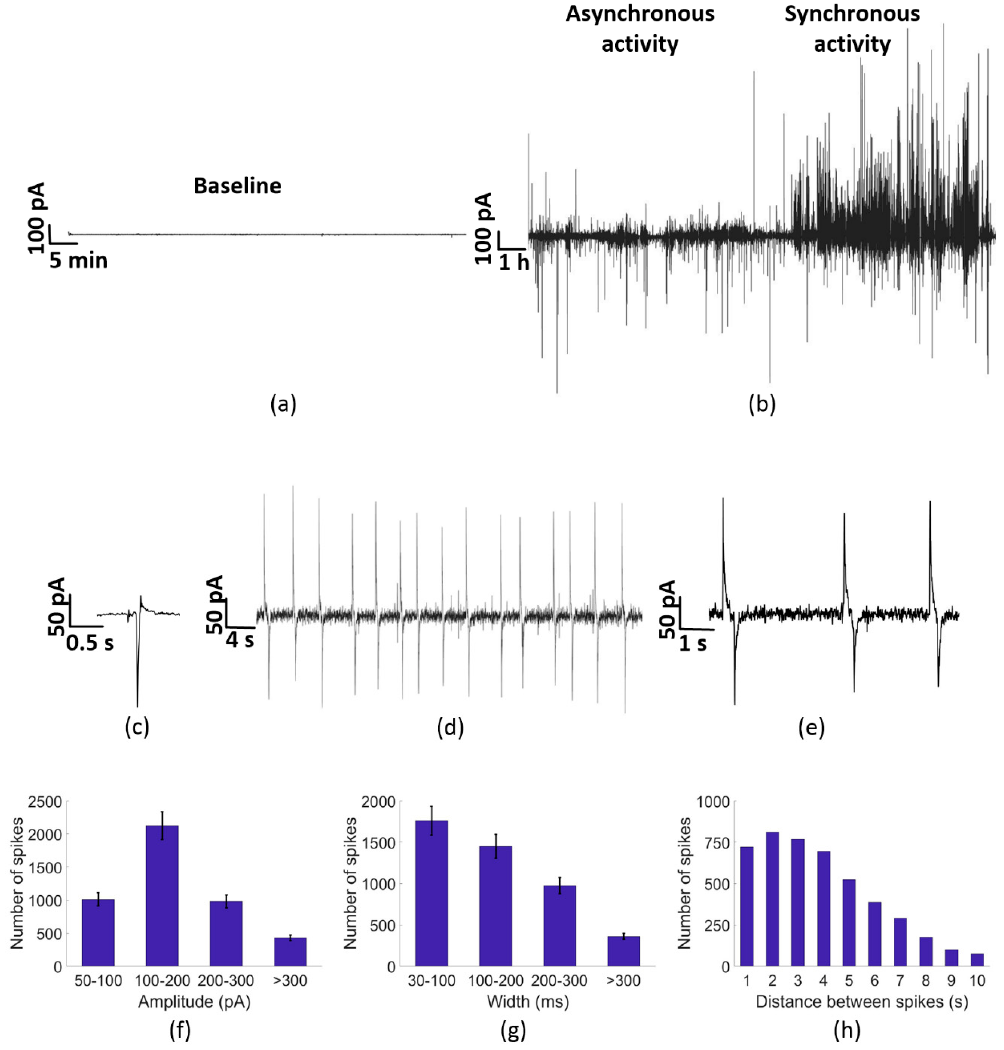
Figure 2. Electrical activity of a PC-3 cells culture on a Si/SiO 2 /Au substrate chip. ( a ) Baseline measured on the chip with only cell medium. ( b ) Most representative electrical activity of PC-3 cells during the experiment, showing on the left side of the graph the sporadic and mostly unipolar electrical activity. ( c ) Zoom-in to the sporadic and asynchronous regime showing a typical unipolar negative spike. ( d ) Quasi-periodic activity of PC-3 cells, presenting Biphasic spikes. ( e ) Biphasic pulses of the electrical activity of PC-3 cells, with a measurable distance between the positive and the negative pulse of about 0.3 s. ( f – h ) represent the characterization of the quasi-periodic activity of PC-3 cells: ( f ) Number of spikes depending on its amplitude. ( g ) Number of spikes depending on its width. ( h ) Number of spikes depending on its distance between them. The interspike intervals were distributed into time slots with a resolution of 1 s.